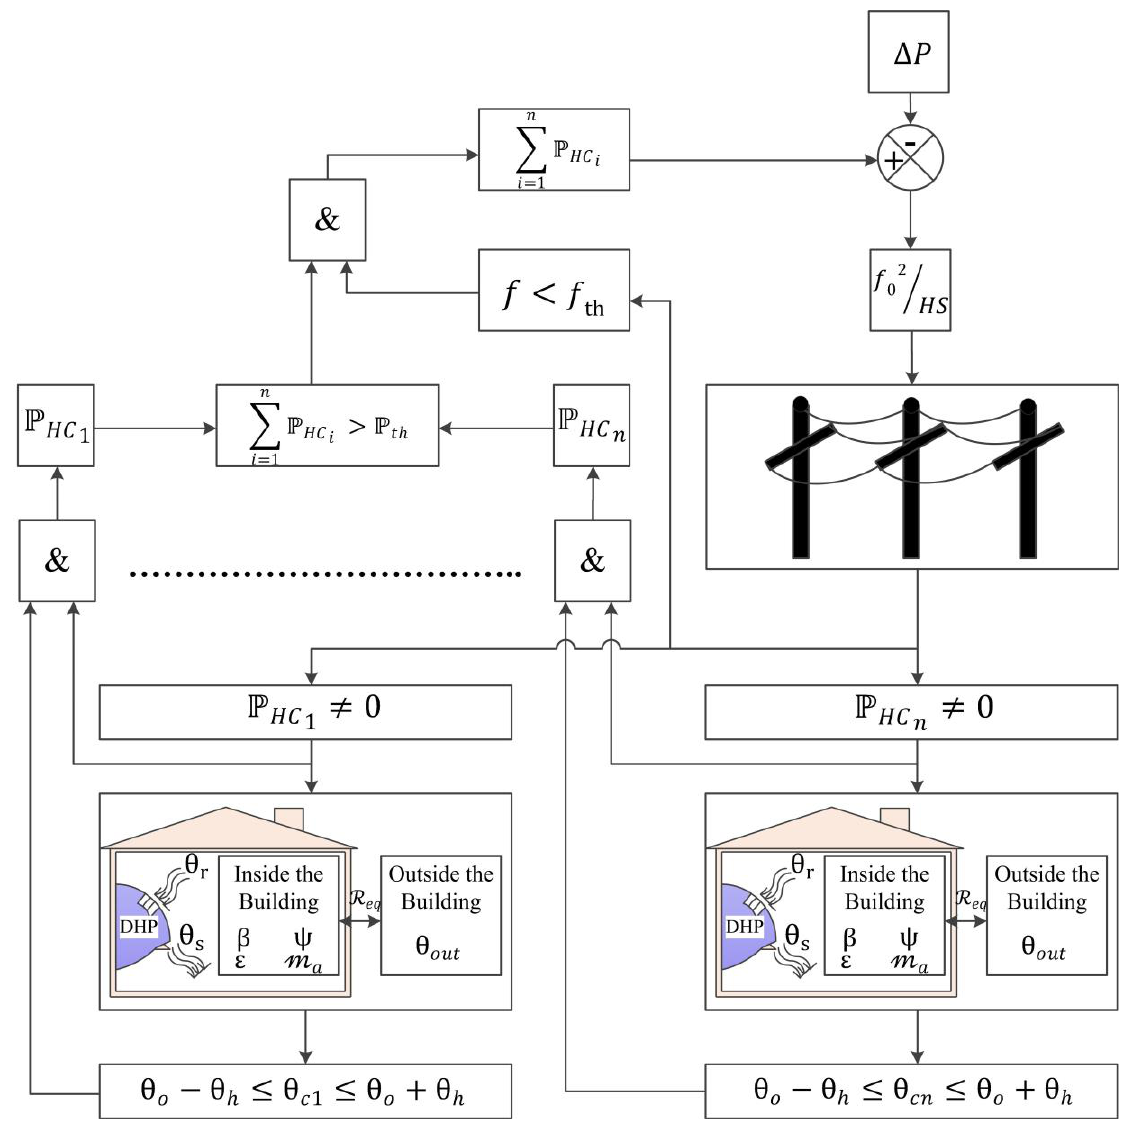
Figure 1. The proposed design of demand response (DR) controller using demand reduction of frequency-controlled DHPs (symbols and abbreviations are defined in the text).